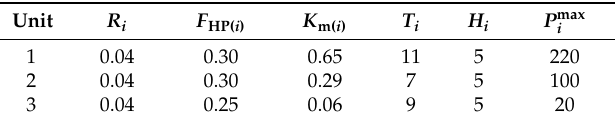
Table A1. Characteristics of Generators for the Six-bus System ( i = 1, 2, 3).